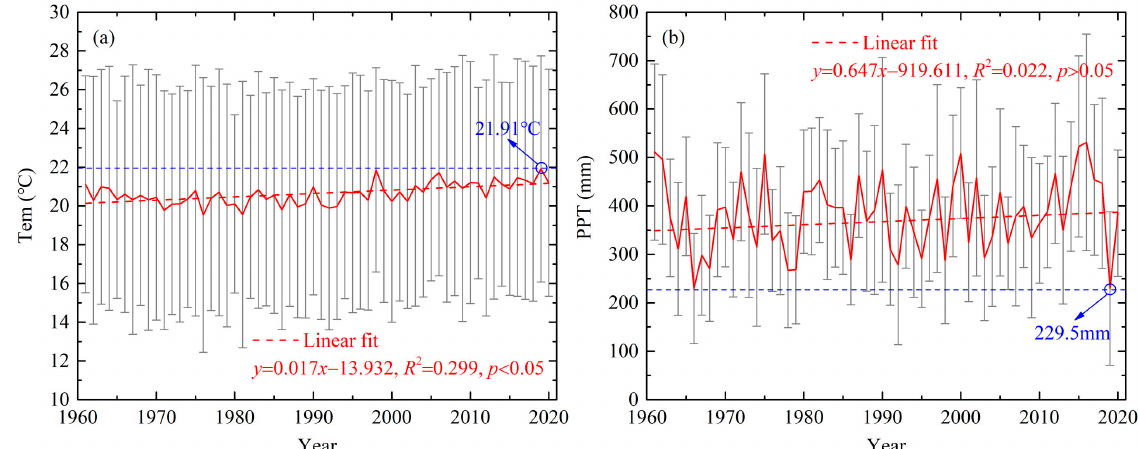
Figure 6. Temporal variations of Tem ( a ) and PPT ( b ) over the MLRYR from August to November during 1961–2020.